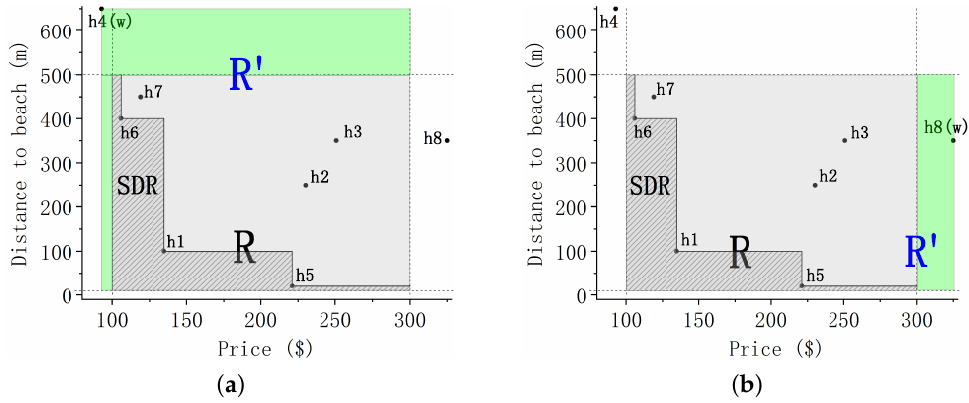
Figure 7. Two examples of the MRE algorithm. ( a ) Point e = h 4 and w ∈ SP ( R (cid:48) ) , MRE. ( b ) Point e = h